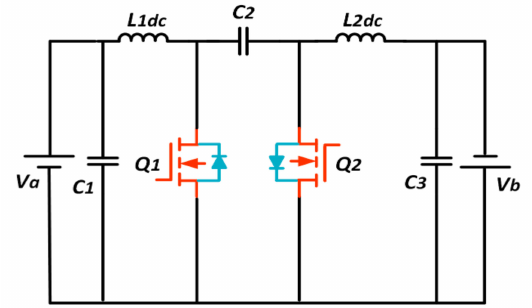
Figure 6. Bidirectional Cuk converter